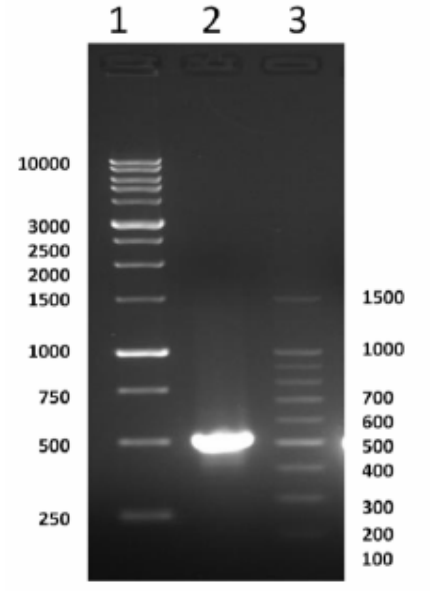
Figure 1. Agarose gel (1.5%) electrophoresis of PCR product of Camelus dromedarius SOD1 (Lane 2). Lane 1 and 3 contain 1 kb and 100 bp DNA molecular weight marker, respectively.